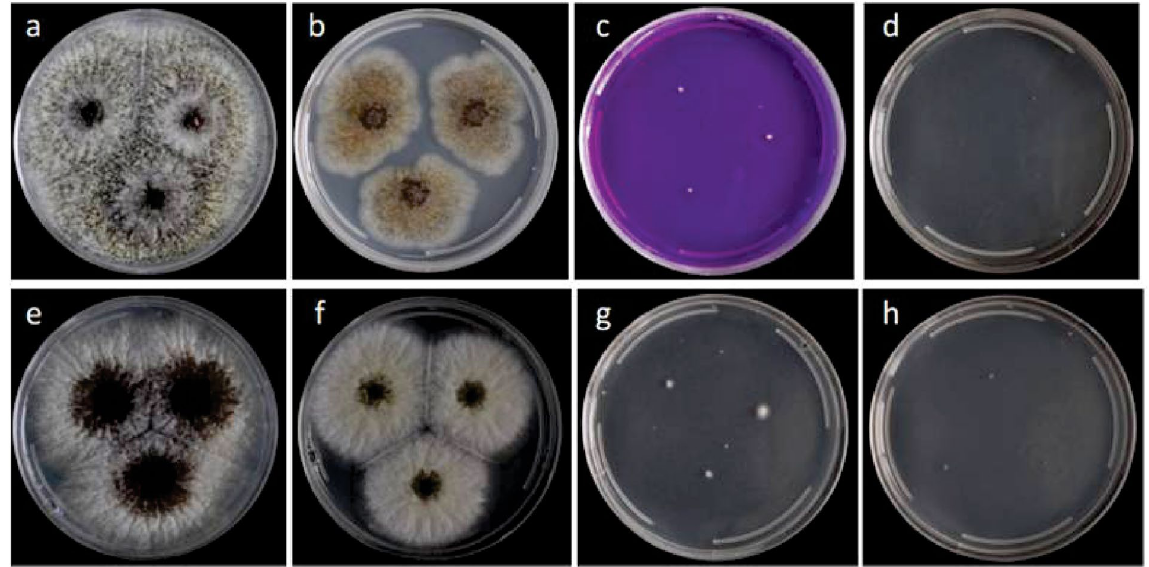
Figure 3. Aspergillus labruscus sp. nov. CCT 7800. ( a ) Colonies on CYA at 25 °C, ( b ) MEA at 25 °C, ( c ) CREA at 25 °C, ( d ) CYA at 33 °C, ( e ) CYA at 30 °C, ( f ) CYA at 20 °C, ( g ) CYA at 15 °C and ( h ) CYA at 10 °C.